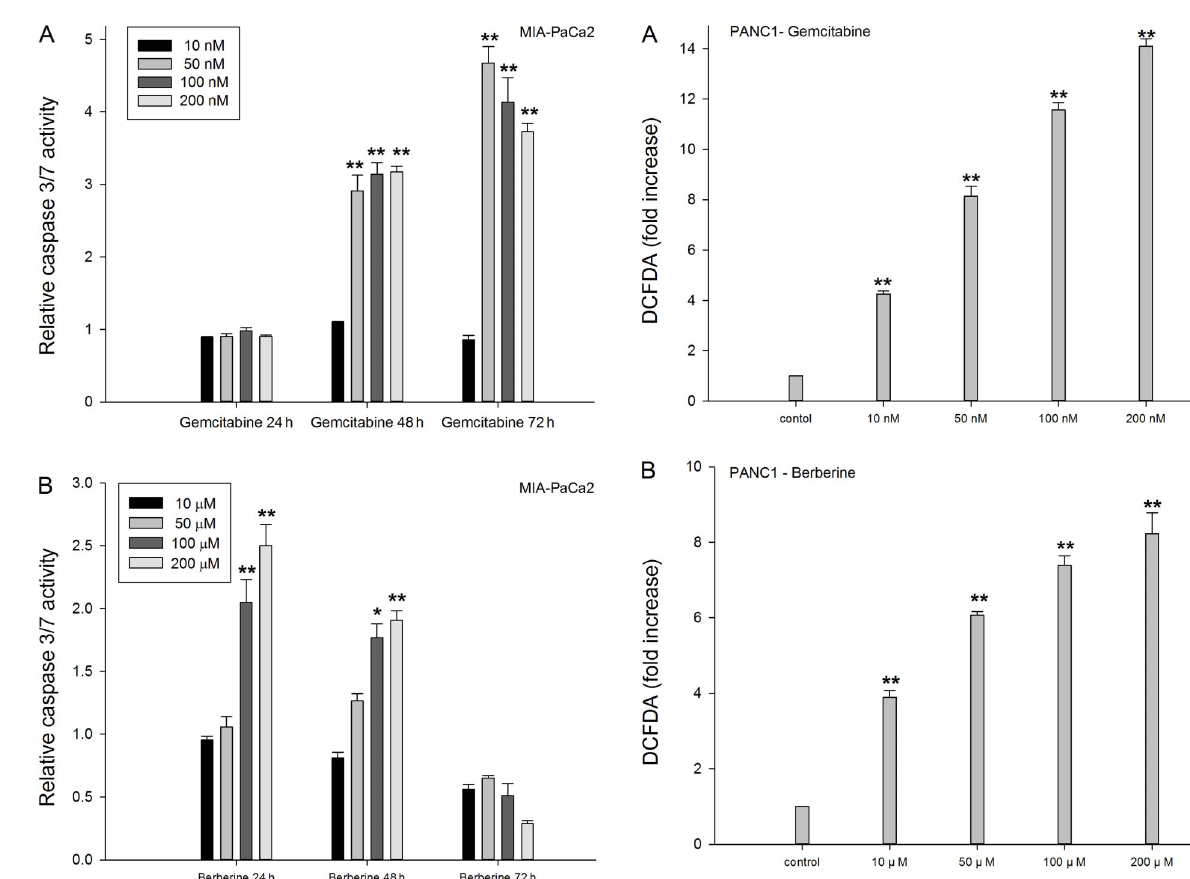
Figure 7. A , Caspase 3/7 activity after treatment of MIA-PaCa2 cells with gemcitabine ( A ) and berberine ( B ) for 24, 48, or 72 h. Data are reported as means±SD activity (n > 3) relative to control. *P , 0.05, **P , 0.01 versus control (Student’s t -test).